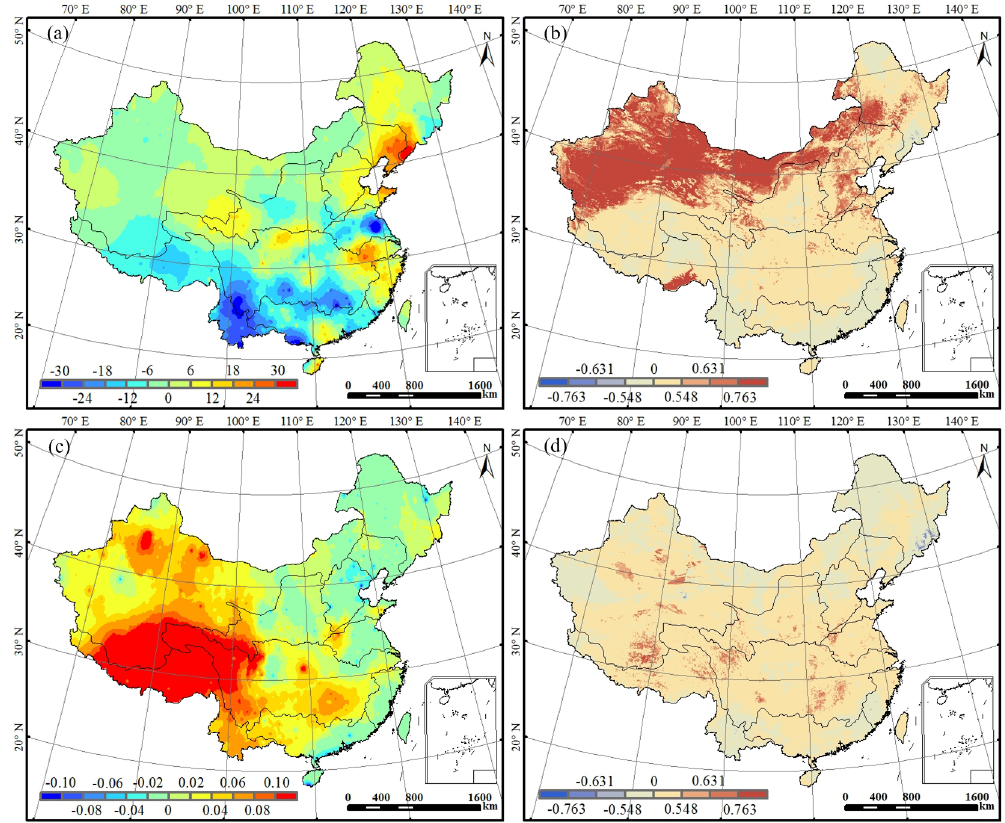
Fig. 12. Temporal trends of (a) annual precipitation (mmyr − 1 ) and (c) mean annual temperature (MAT) ( ◦ Cyr − 1 ). Partial correlation coefficients for (b) annual precipitation and (d) MAT in relation to ET from 2000 to 2010. Partial correlation coefficients of 0.548, 0.631, and 0.763 indicate respective significance levels of 0.10, 0.05, and